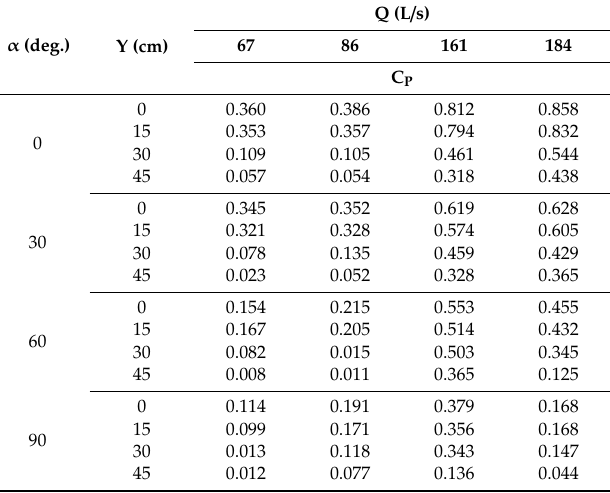
Table 1. Values of mean dynamic pressure coe ffi cients obtained in this research